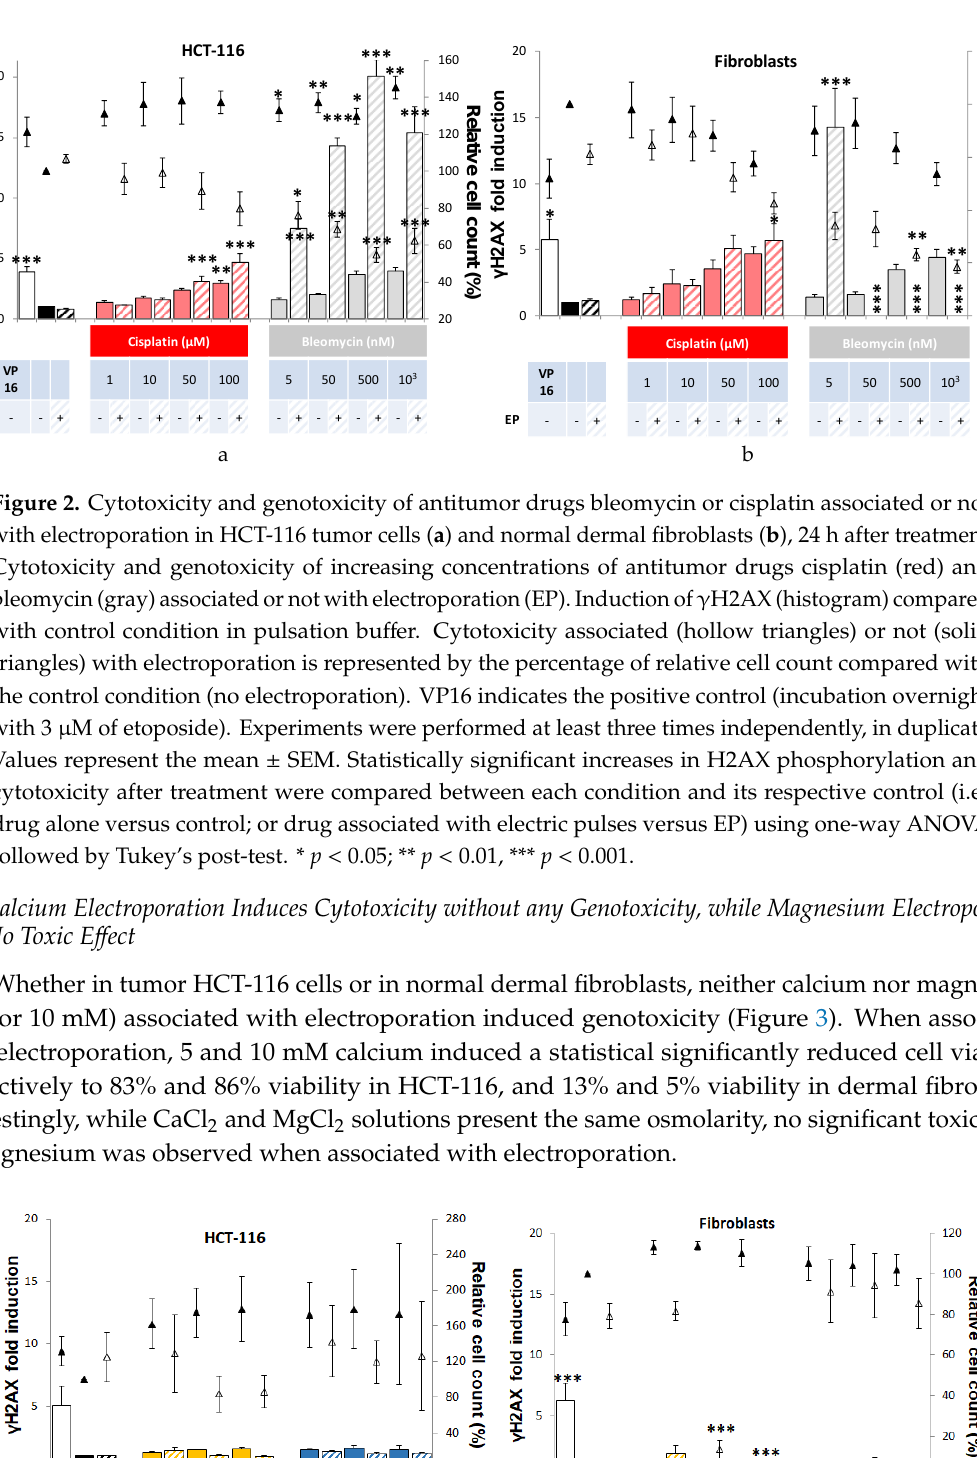
Figure 3. Cytotoxicity and genotoxicity of CaCl 2 or MgCl 2 associated or not with electroporation in HCT-116 ( a ) and normal dermal fibroblasts ( b ), 24 h after treatment. Cytotoxicity and genotoxicity of increasing concentrations of CaCl 2 (yellow) and MgCl 2 (blue), associated or not with electroporation